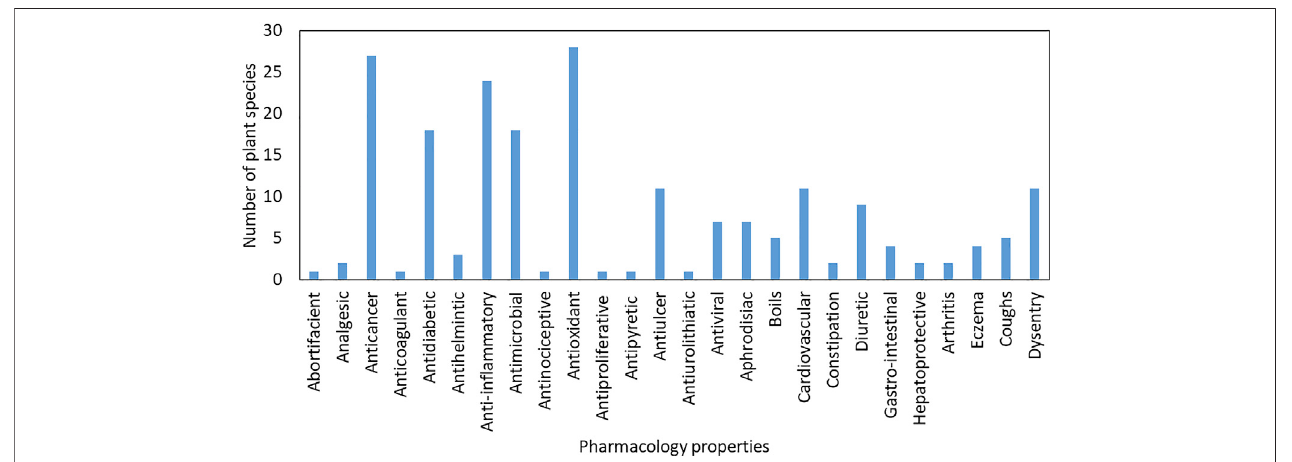
FIGURE4| Totalfrequencyofarticlesciting pharmacological properties possessedbyneglected and underutilisedfunctionalmedical crops foundinSouth Africa.